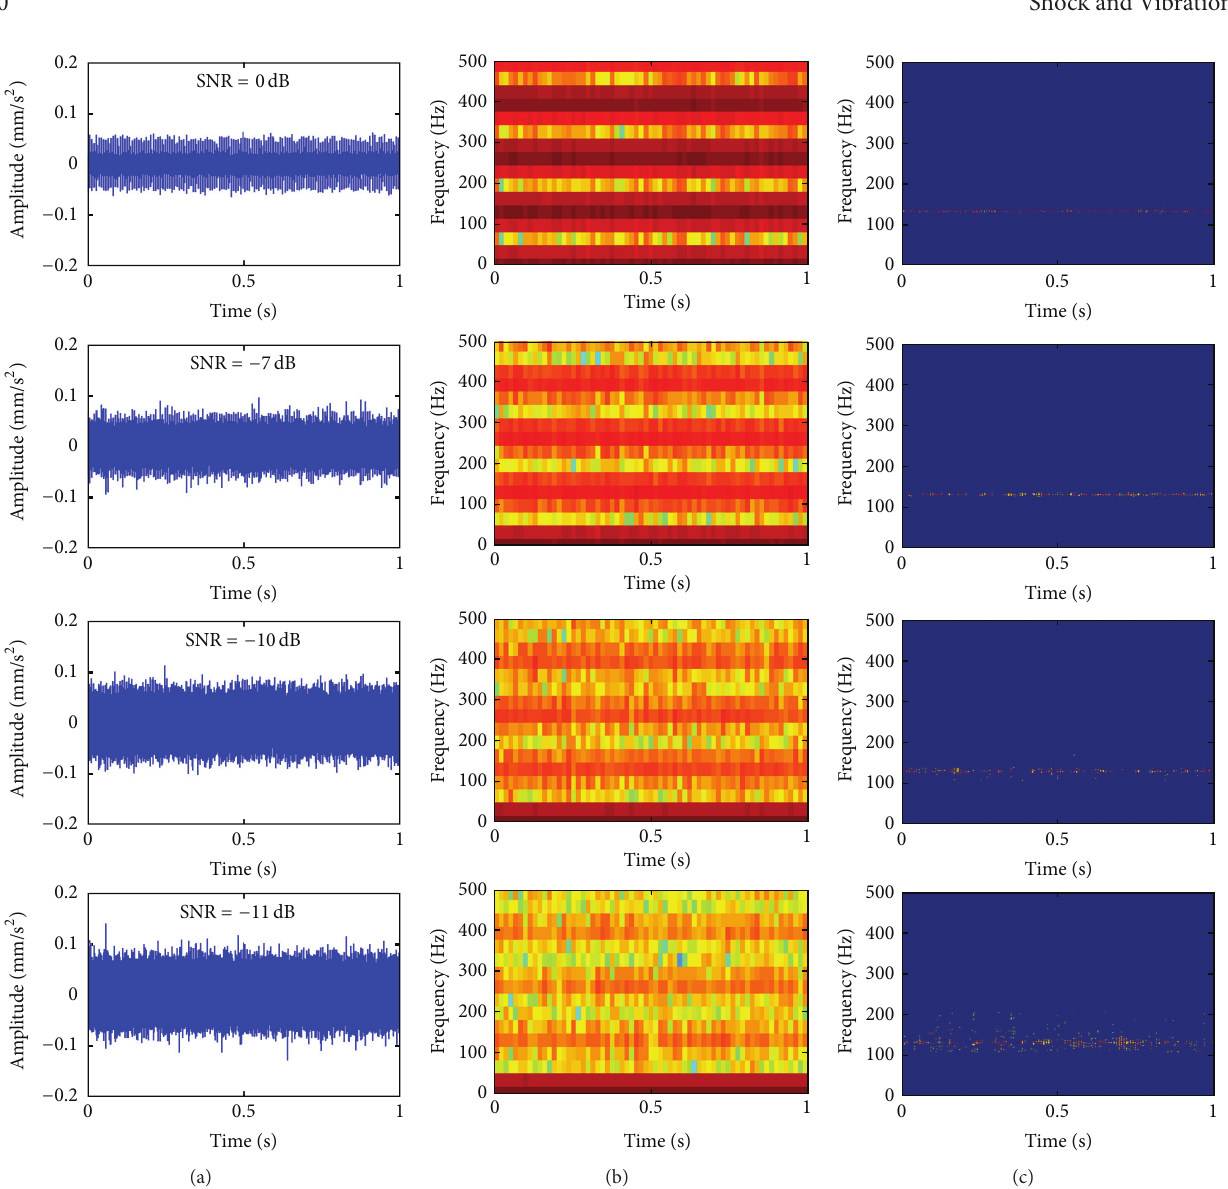
of the signal as shown in Figure 12(a) by SPM, shock pulse frequency spectrum analysis method, shock pulse